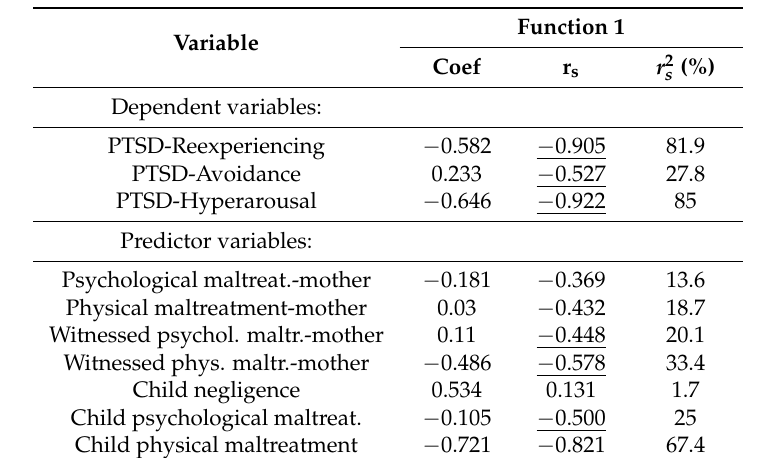
Table 6. Canonical solution for types of maltreatment predicting child PTSD symptoms for Function